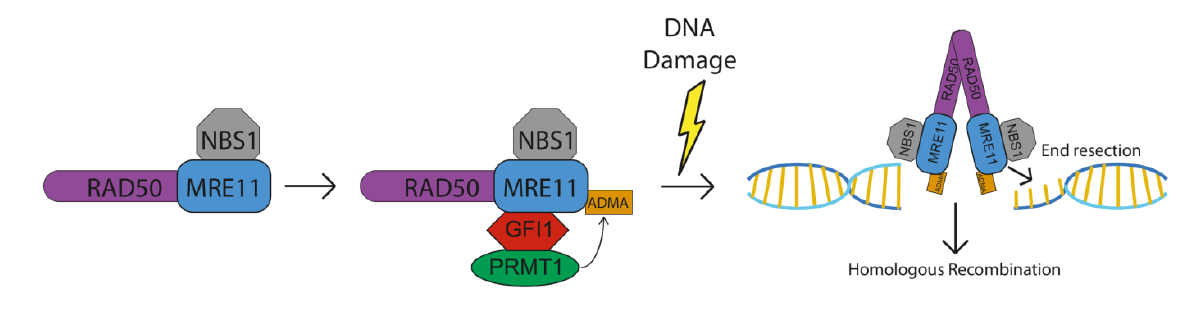
FIGURE 1: Model for the action of GFI1 in DNA repair. GFI1 acts as a bridge between the PRMT1 methyltransferase and key DNA repair proteins to promote their activity. Methylation of MRE11 and the corresponding facilitation of HR repair are shown as an example of this activity of